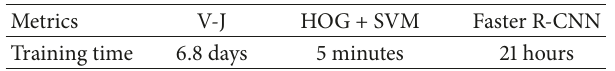
Figure 10: Sensitivity of detection speed to different detection load (tested on GPU). Table 3: Training